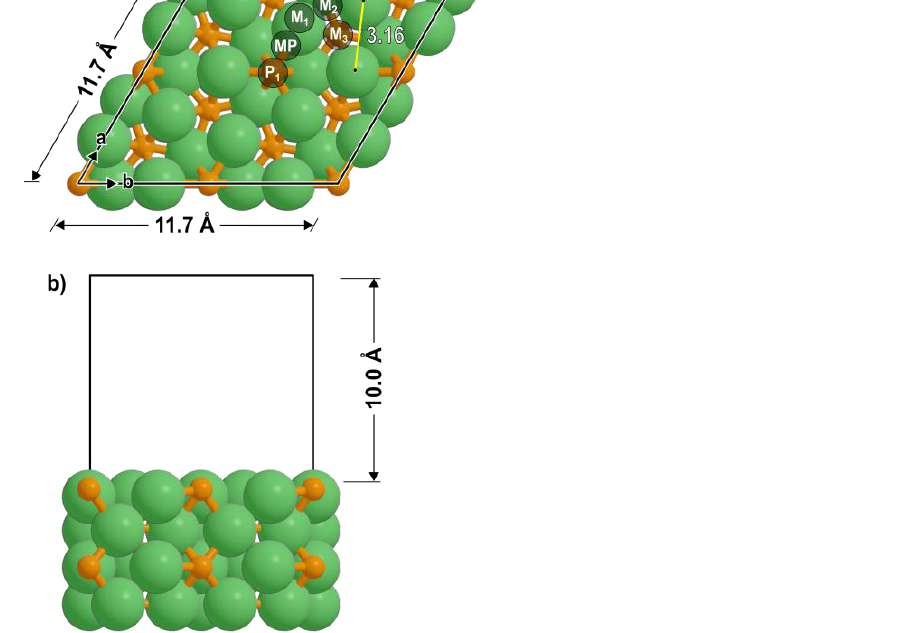
Figure 4. ( a ) Top and ( b ) side views of the Ni 2 P(001) model used in this study. The adsorption sites are labeled as M 1 : metal atop, M 2 : metal bridge, M 3 : metal three-fold hollow, MP: metal-phosphorus bridge, and P 1 : phosphorus atop. The atoms in the bottom unit (two atomic layers) were fixed in their bulk positions while all other atoms were relaxed.